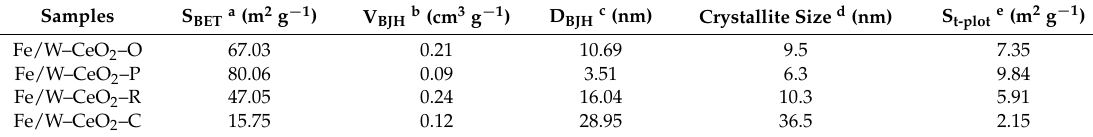
Figure 2. XRD patterns of Fe/W–CeO 2 catalysts. Table 1. Physical properties of Fe/W–CeO 2 catalysts.